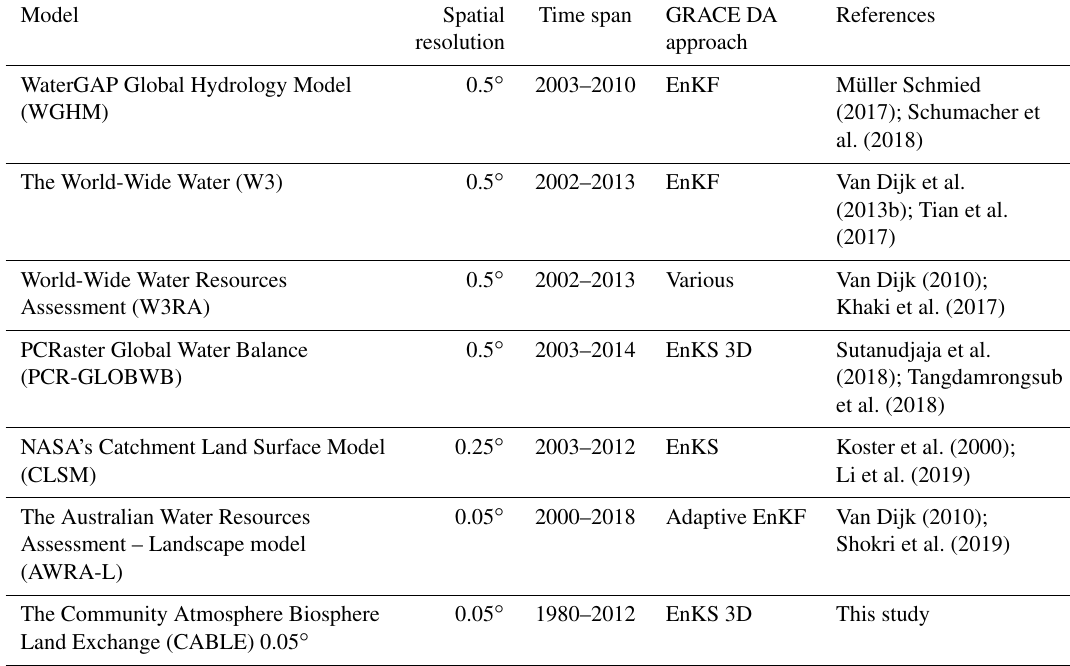
Table 1. Relevant studies related to the development of the land surface and hydrology models (with the inclusion of GRACE DA applica- tions) to estimate TWS in Australia.